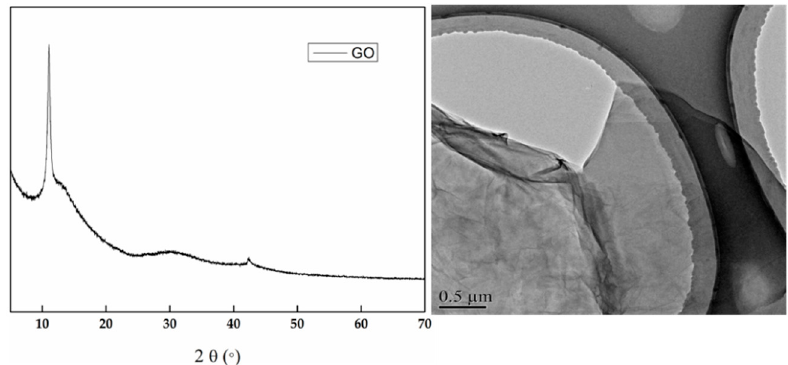
Figure 1. XRD and the TEM of Graphene oxide (GO).